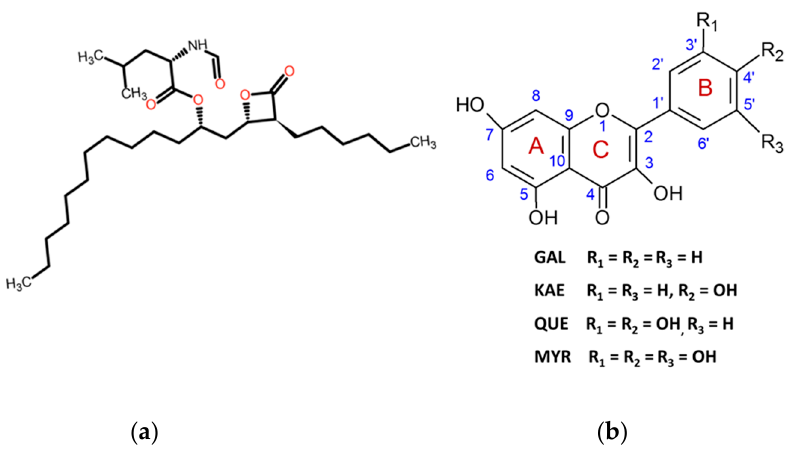
Figure 1. Chemical structures of ( a ) orlistat (tetrahydrolipstatin; THL) and ( b ) investigated flavonols in this study: GAL, galangin; KAE, kaempferol; QUE, quercetin; MYR, myricetin. Flavonol skeleton shows the numbering system of three rings A, B and C.